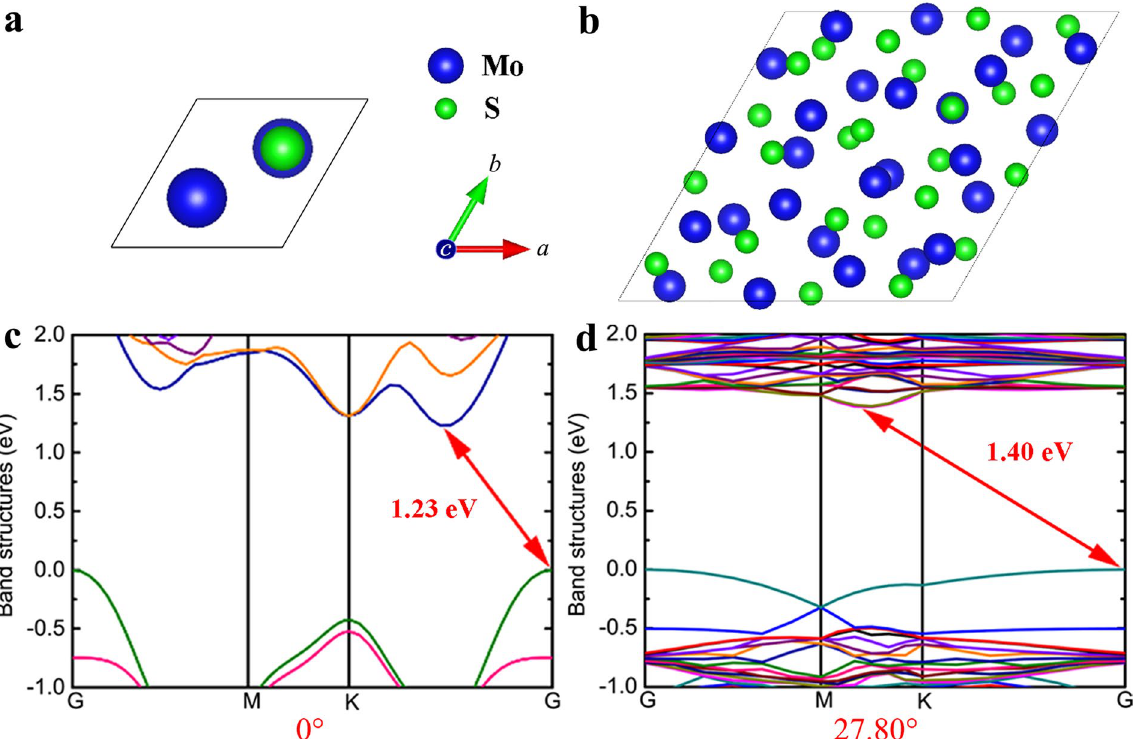
Figure 4. First-principles results of the bilayer MoS 2 sheets without RSFs and with a RSF of 27.80°, of which the former is standard AB-stacked and can be considered to contain a RSF of 0°. ( a , b ) Top views of the unit cells of the two materials, where the c direction equals the z in Fig. 1a,b. ( c , d ) Electronic structures of the two materials obtained by the first-principles calculations, where the two ends of each arrow indicate the positions of CBM and VBM. The red numbers with the unit of eV denote the indirect bandgap values.